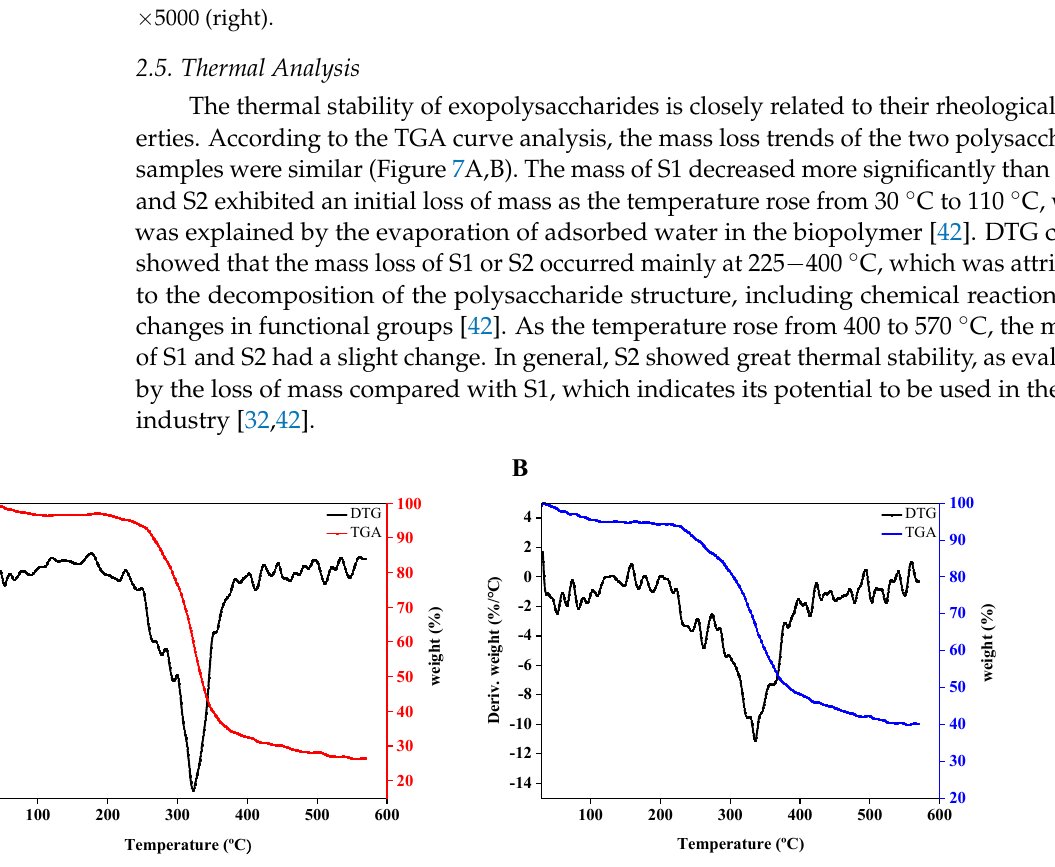
Figure 7. Thermal analysis of EPS. S1 ( A ), S2 ( B ), TGA curves (red line and blue line), DTG curves (black line).